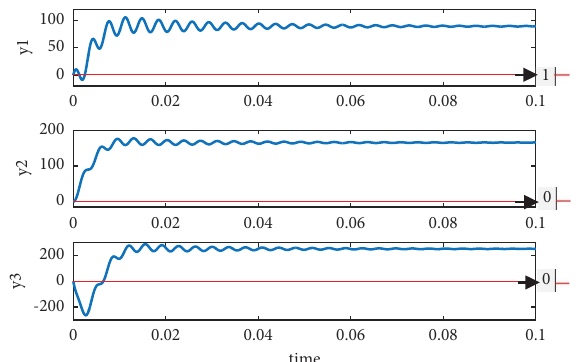
Figure 6: System response in the second mode to input [ u ] T � [1 0